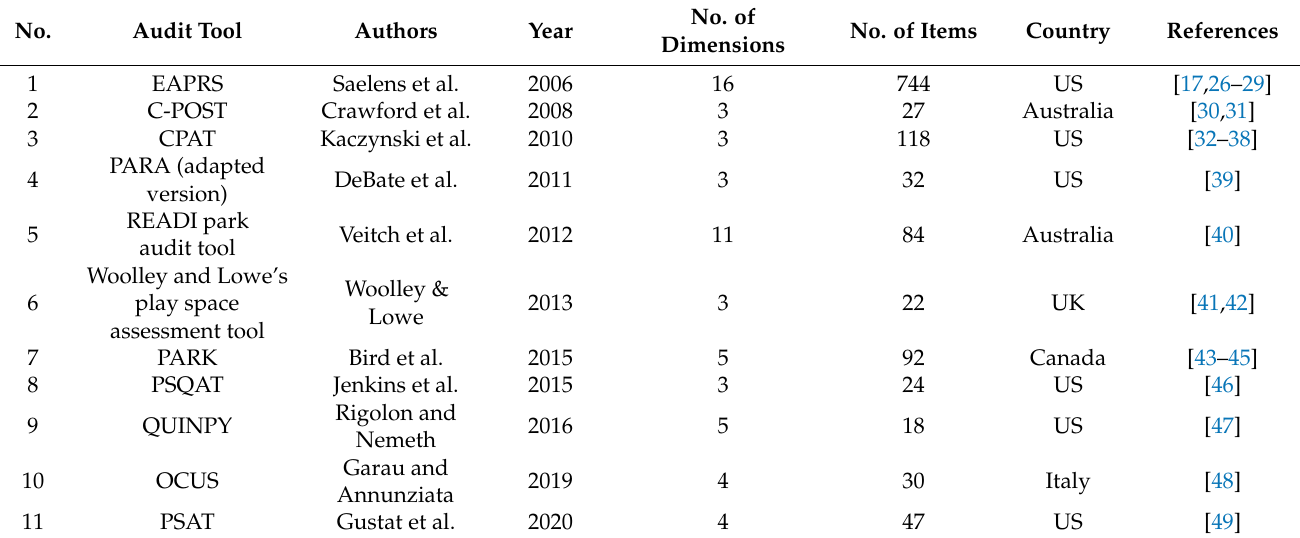
Table 1. Summary of the audit